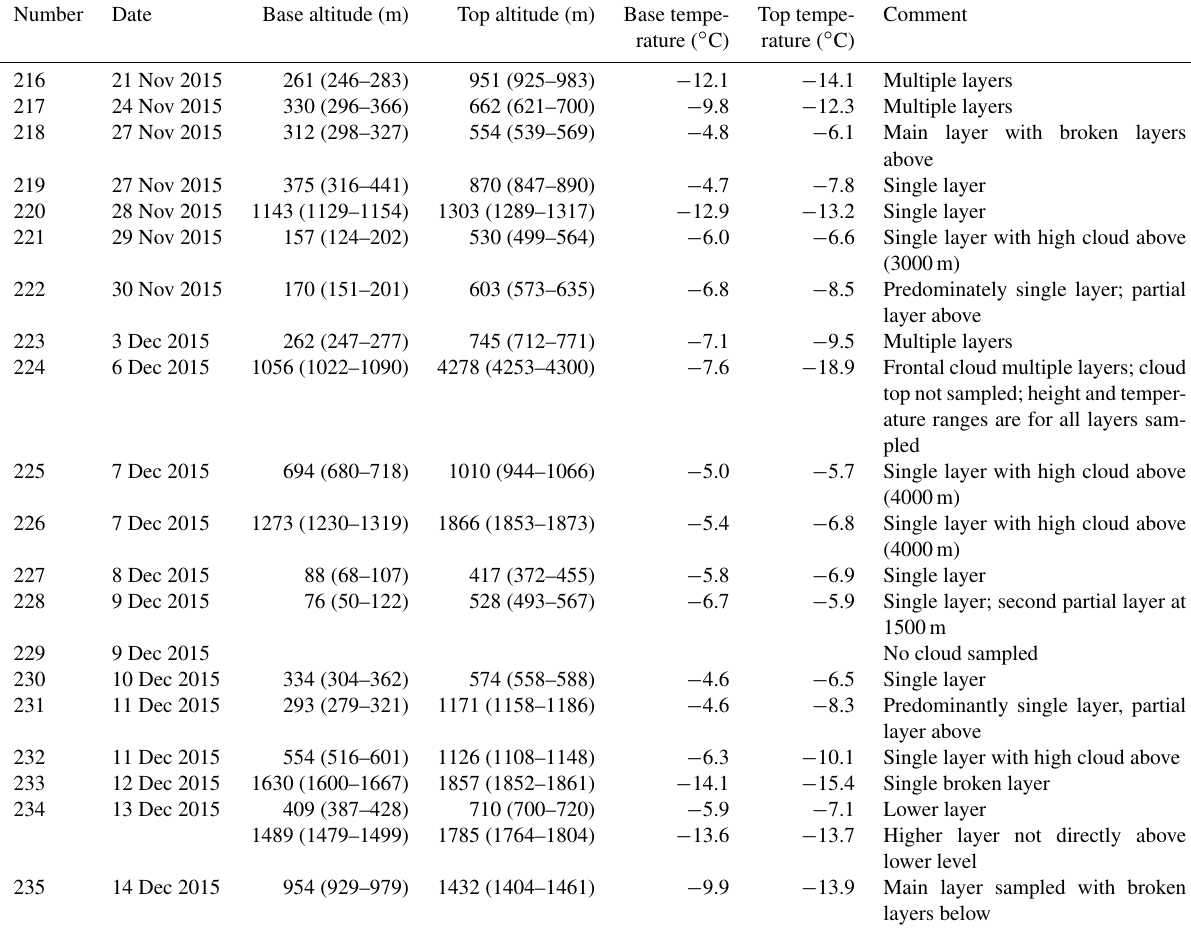
Table 1. The height and temperature of cloud base and top for each flight. The ranges of altitudes in brackets are an estimate of the uncertainty in the cloud heights due to a combination of variability in the cloud and incomplete sampling. If multiple layers were present, unless noted otherwise, the height and temperatures given are for the main cloud layer